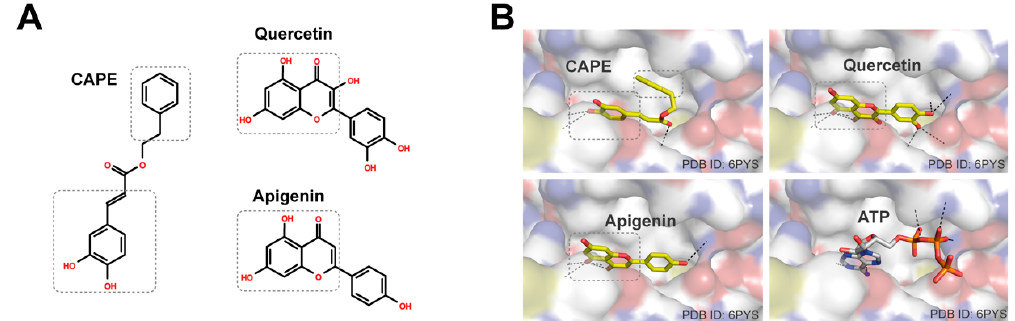
Figure 6. Structures of bioactive compounds and their structural models on phosphoinositide 3-kinase (PI3K) (p110 α catalytic subunit). ( A ) The 2D structures of ca ff eic acid phenethyl ester (CAPE), quercetin, and apigenin. The moieties interacting with PI3K were highlighted with dashed boxes; ( B ) The structural models of CAPE, quercetin, and apigenin on PI3K (p110 α catalytic subunit). ATP was located on human PI3K by superimposing the structure of porcine PI3K co-crystallized with ATP to the human PI3K and displaying its ATP part.